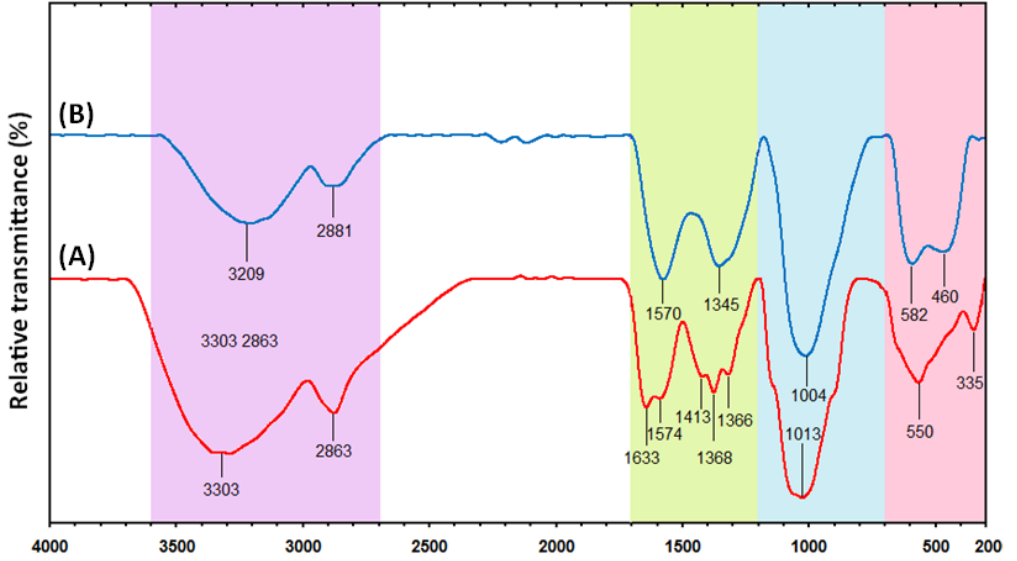
Figure 4. ( A ) FT-IR spectra of pure chitosan and ( B ) Cu-NPs synthesized in chitosan